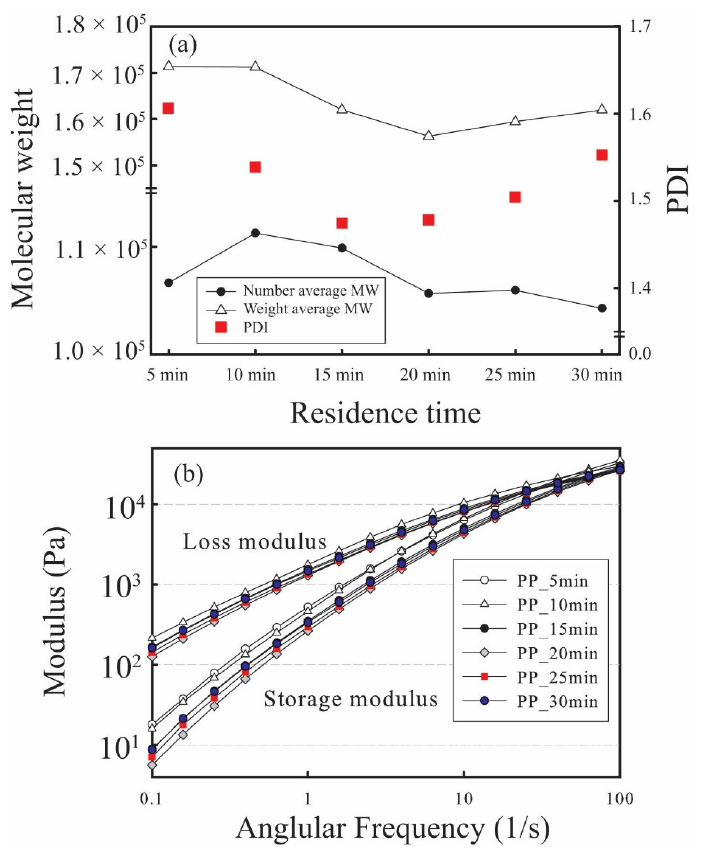
Figure 3. ( a ) Number, weight-average molecular weight, and polydispersity index (PDI) of PP as a function of residence time; ( b ) storage modulus G (cid:48) and loss modulus G (cid:48)(cid:48) of PP as a function of residence time at 200 °C.